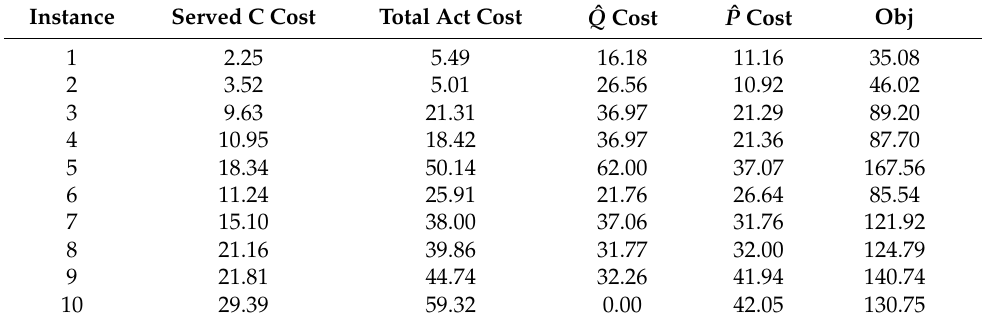
Table 5. Results of the instances of Table 4 with all the cost components of the objective function.